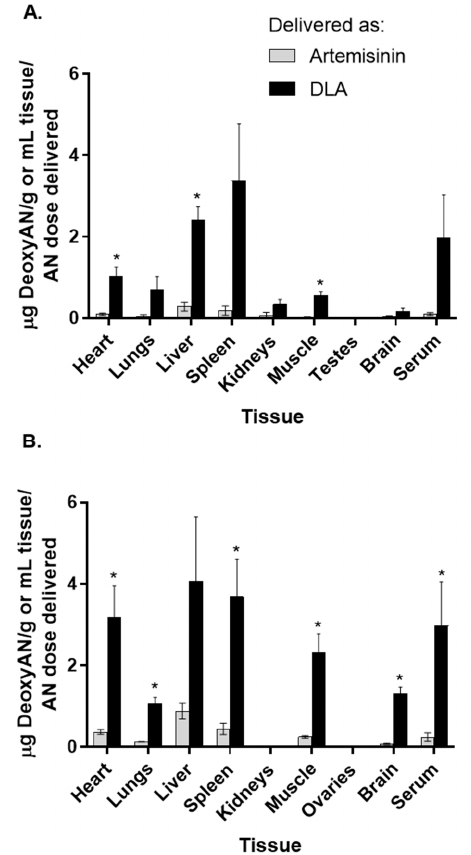
Figure 3. Deoxyartemisinin (deoxyAN) distribution in tissues and serum of male ( A ) and female ( B ) rats after oral delivery of artemisinin as dried leaf A. annua (DLA) or pure artemisinin. n = 3, *; p ≤ 0.05; error bars =